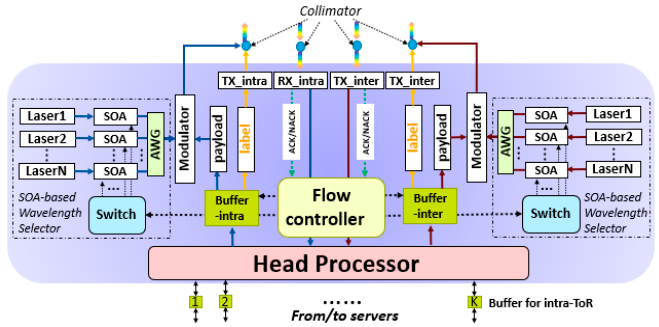
Figure 2. The functional blocks of FPGA ‐ based ToR switch.